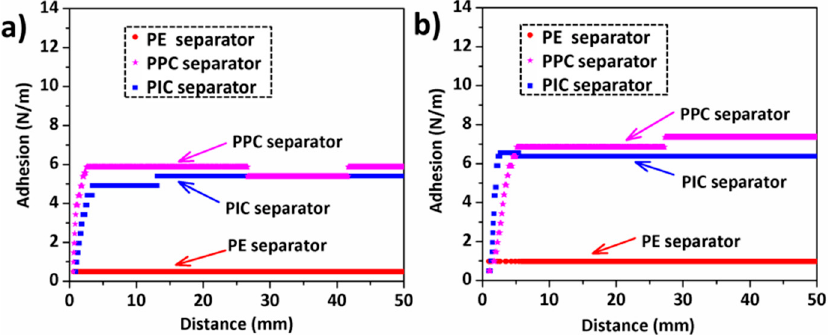
Figure 7. The adhesion strength between separator and ( a ) anode, ( b ) cathode for pouch cells with different separators.